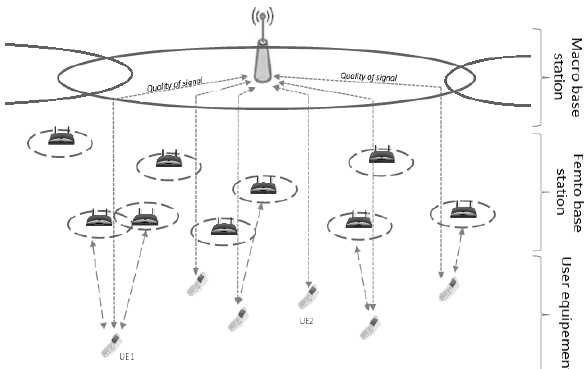
Figure 1: Heterogeneous LTE architecture: a mobile user can detect macrocells (UE2) only, or macrocells and femtocells